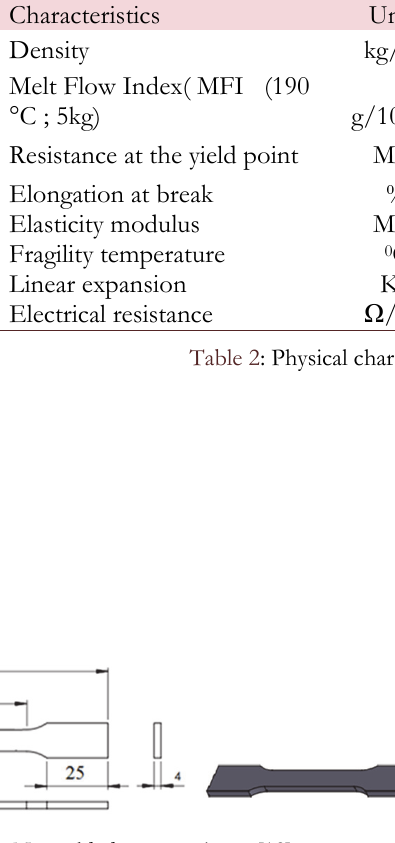
Figure 2: No welded test specimen [12]. Figure 3: Stress-Strain curve (non-welded test specimen) in the strain rate.